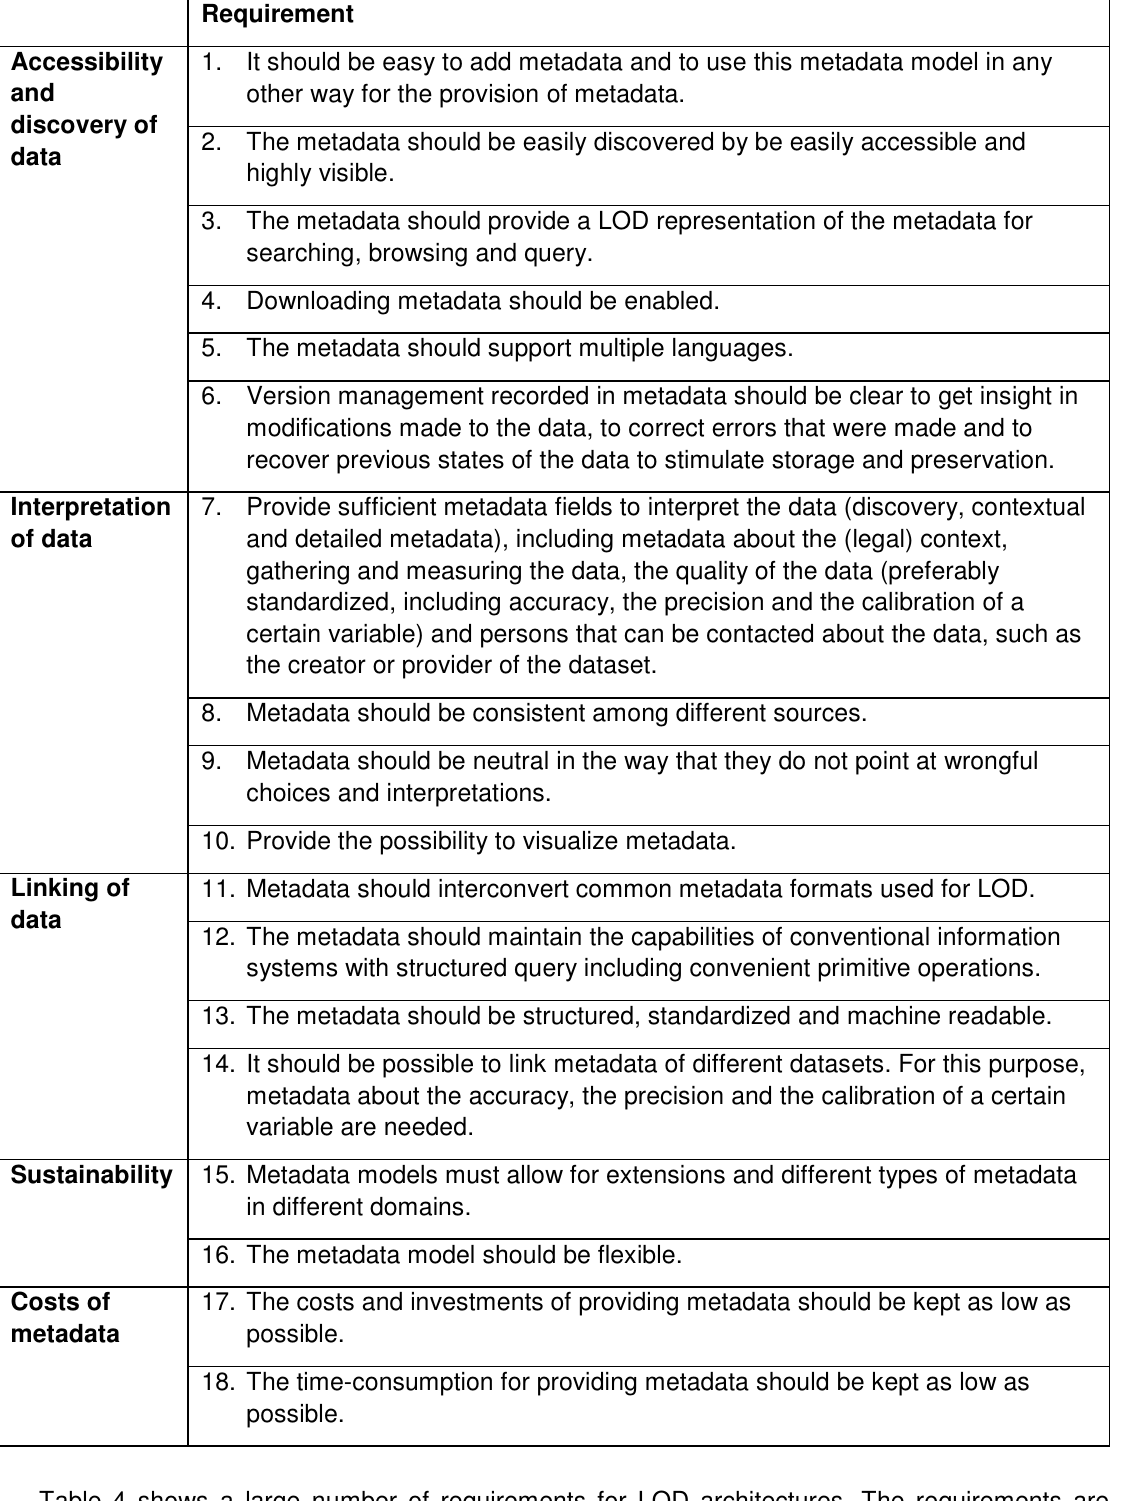
Table 4: Overview of metadata requirements for LOD